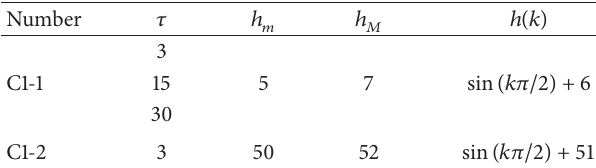
Table 2: The conditions of simulation in Example